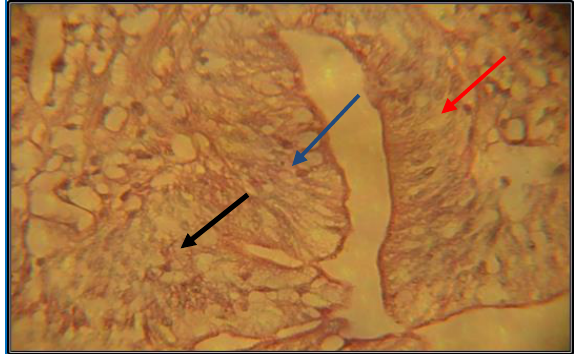
Figure, 7: Intestine of 3rd group after 48hrs. heat exposure showed ( ) cellular debress in their lumen and marked cellularity of the laminapropria ( ) with vacculation of lining cells ( ) (H and E stain 400X).